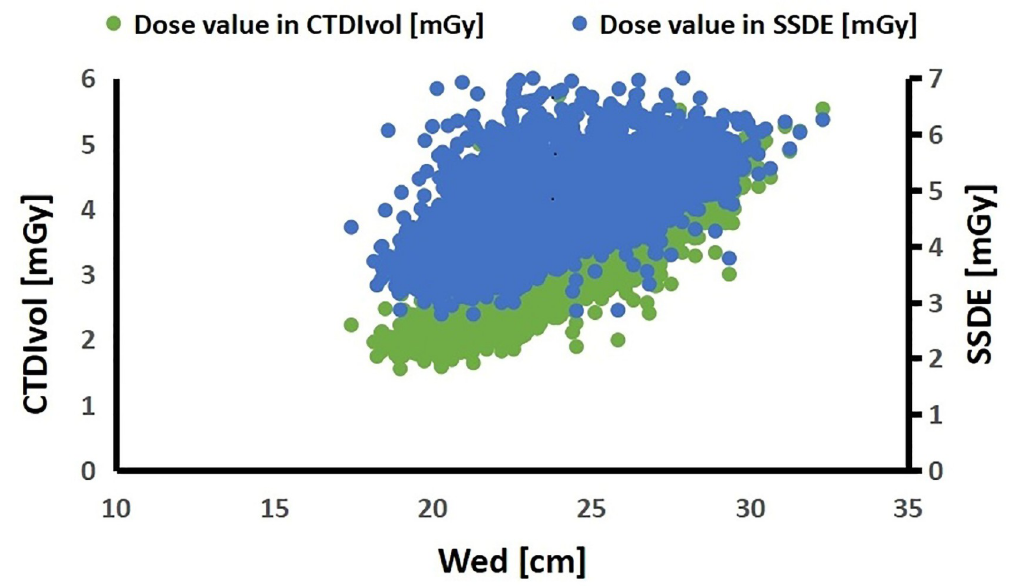
Fig 2. Scatter plots of CTDIvol, SSDE and Dw. The CTDIvol and SSDE increased as function of Dw.